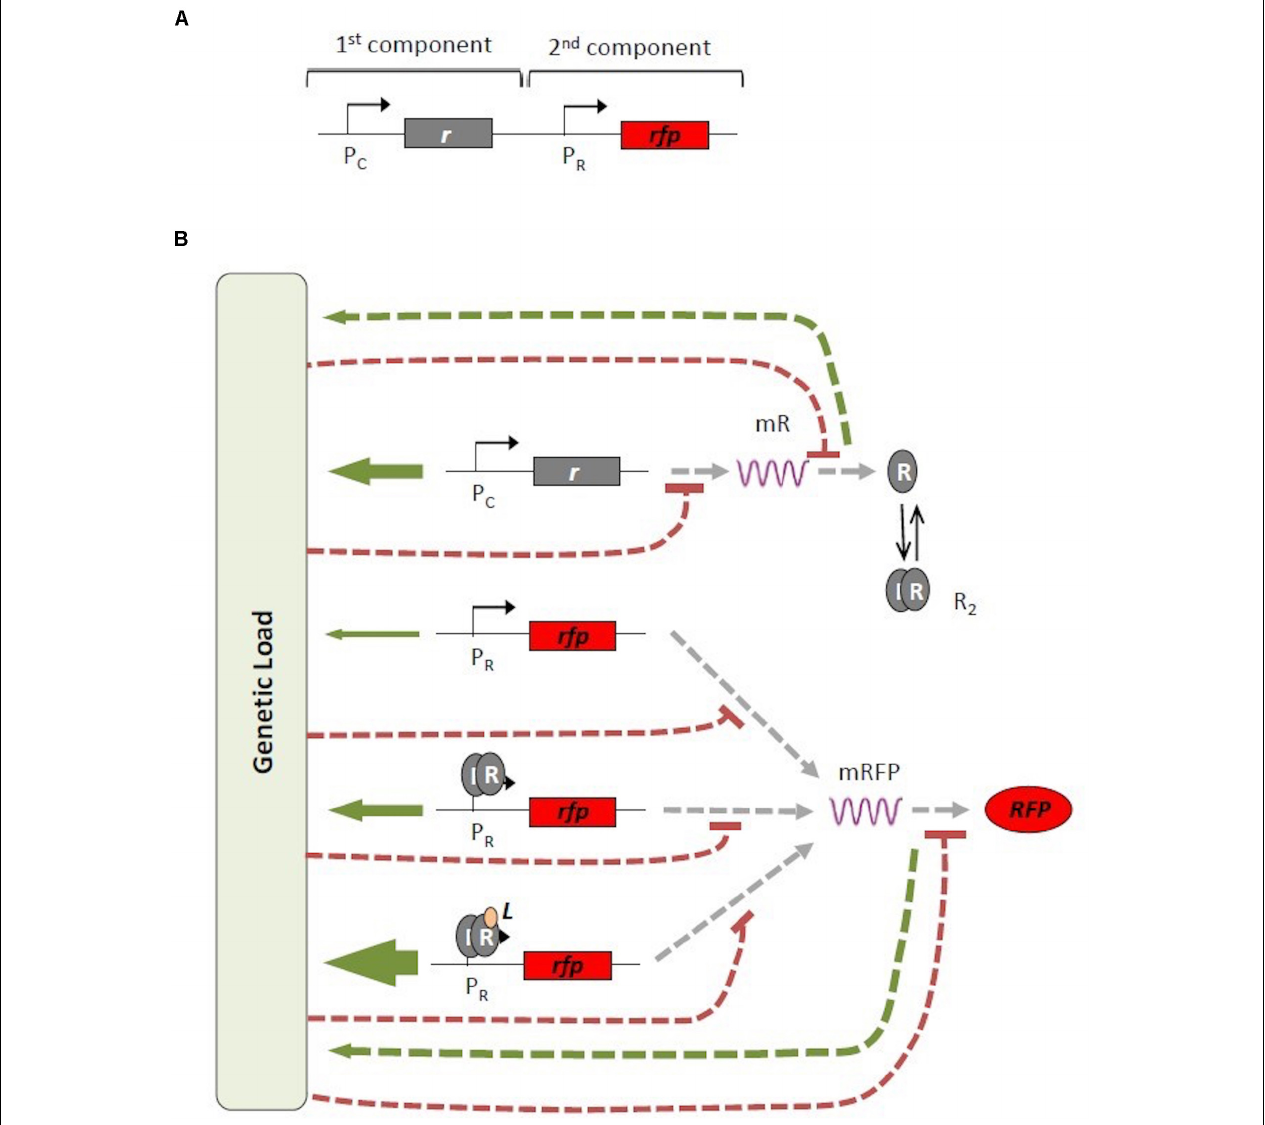
FIGURE 1 | Map of interactions associated with genetic burden. (A) Generic architecture of an inducible signal transduction system. The promoter and gene for the receptor protein R [Pc and gray (r) boxes, respectively] and the promoter and gene for the red fluorescent protein [Pr and red (rfp) boxes, respectively] are indicated. (B) Different mechanisms or modes of gene expression. Receptor protein R is constitutively produced (top row). RFP can be produced in three different ways: constitutively (second row); induction by a dimeric complex of the receptor protein R 2 (third row); or induction by a transcriptional complex formed by the dimeric R 2 combined with an external signal L (fourth row). All possible transcriptional and translational paths contribute to the total genetic burden with different weights (green arrows), Simultaneously, genetic burden generates a negative effect (dashed red line) on gene transcription and translation. mRFP, messenger RNA for R and